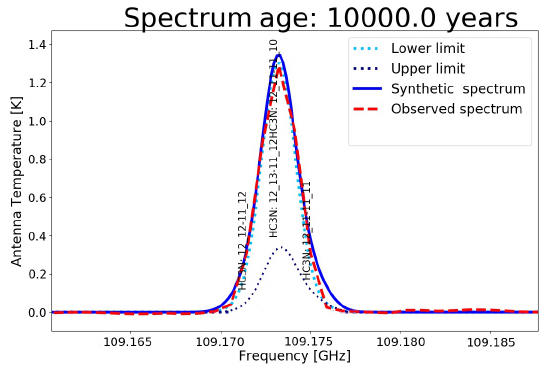
Figure 3. Example of a transition with hyperfine structure. Note: due to the large column density of the upper limit, the line becomes optically thick, blocking its own signal.